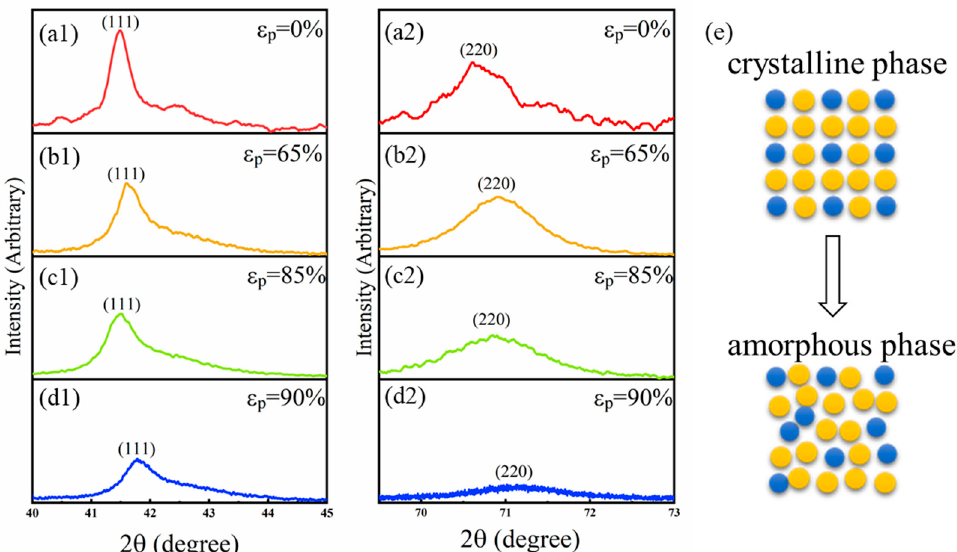
Figure 1. XRD patterns with two characteristic peaks (( a1 – d1 ) (111), ( a2 – d2 ) (220) peaks) of FCC structure of the specimens with different thickness reduction ε p (( a ) original specimens, ε p = 0%, ( b ) ε p = 65%, ( c ) ε p = 85%, and ( d ) ε p = 90%)) at 300 K. ( e ) The schematics for the case where the crystalline phase is disrupted into the amorphous phase.